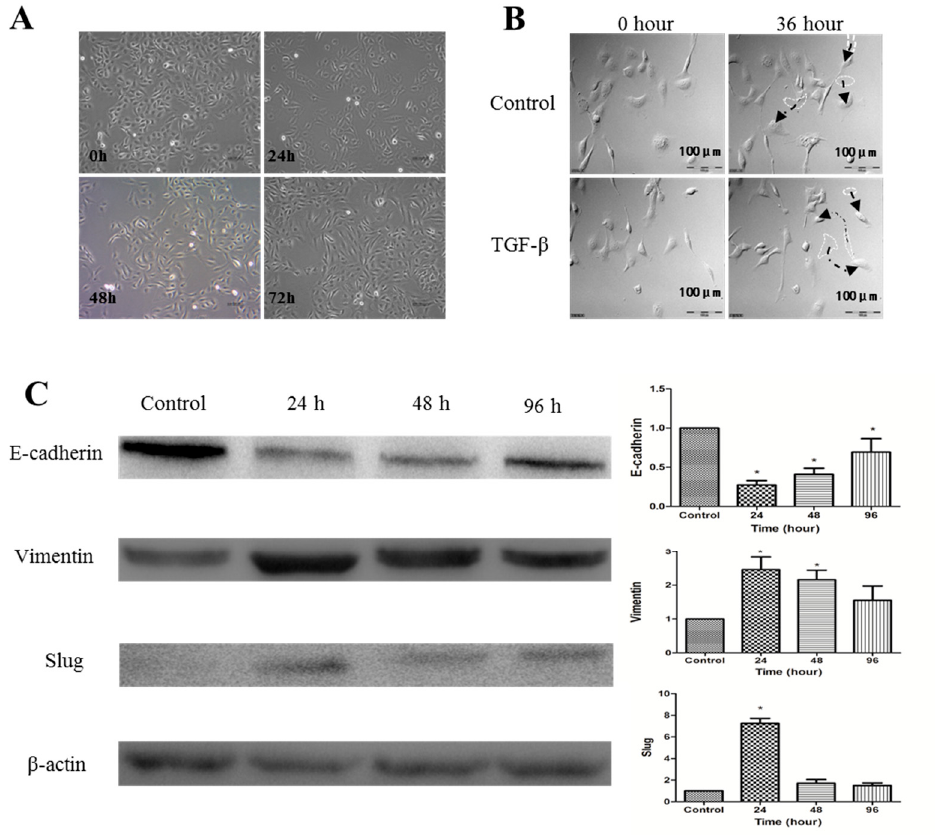
Figure 2. Transforming growth factor- β 1 (TGF- β 1) induces EMT of SKOV-3 cells. ( A ) SKOV-3 cells were exposed to 10 ng/mL of TGF- β 1. Compared to the group of control, TGF- β 1-treated SKOV-3 cells lost their cobblestone shape and adopted a fibroblast-like, spindle-shaped morphology. Morphology photographs were taken at 24, 48, and 72 h (magnification of 400×); ( B ) analyses with a Live Cell Imaging System showed that the movement distance increased further after SKOV-3 cells were treated with TGF- β 1 for 36 h than control cells (Arrows refer to the movement track of SKOV-3 cells); ( C ) Left : Western blot analysis of the indicated proteins in SKOV-3 cells. β -actin served as a loading control; Right : the level of the indicated protein was quantified with gray value. The data represent the Mean ± SD. * p < 0.05 versus